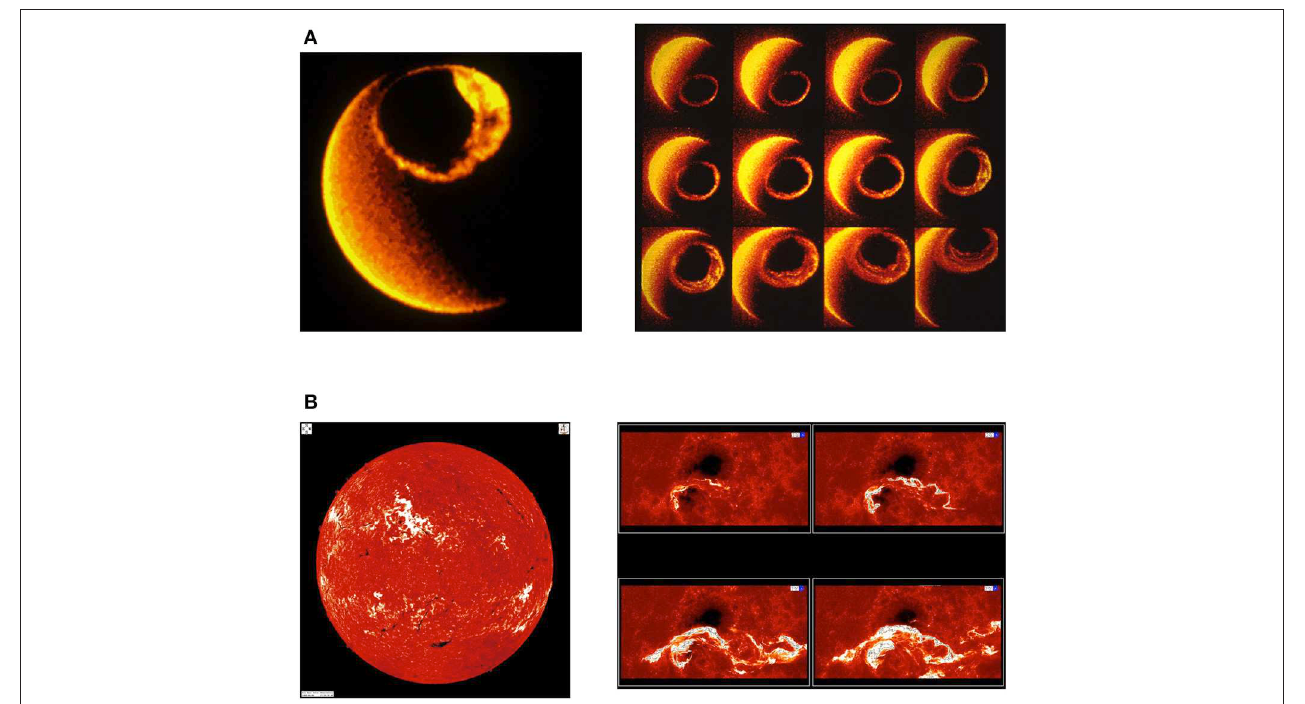
FIGURE 1 | (A) A global view of an auroral substorm and an example of its development (Courtesy of L. Frank). (B) A global view of a solar flare and an example of its development (adopted from Figure 1 in “Rotating eruption of an untwisting filament triggered by the 3B flare of 25 April 1984, Kurokawa et al. (1987); permission from Springer Nature; Courtesy of K.